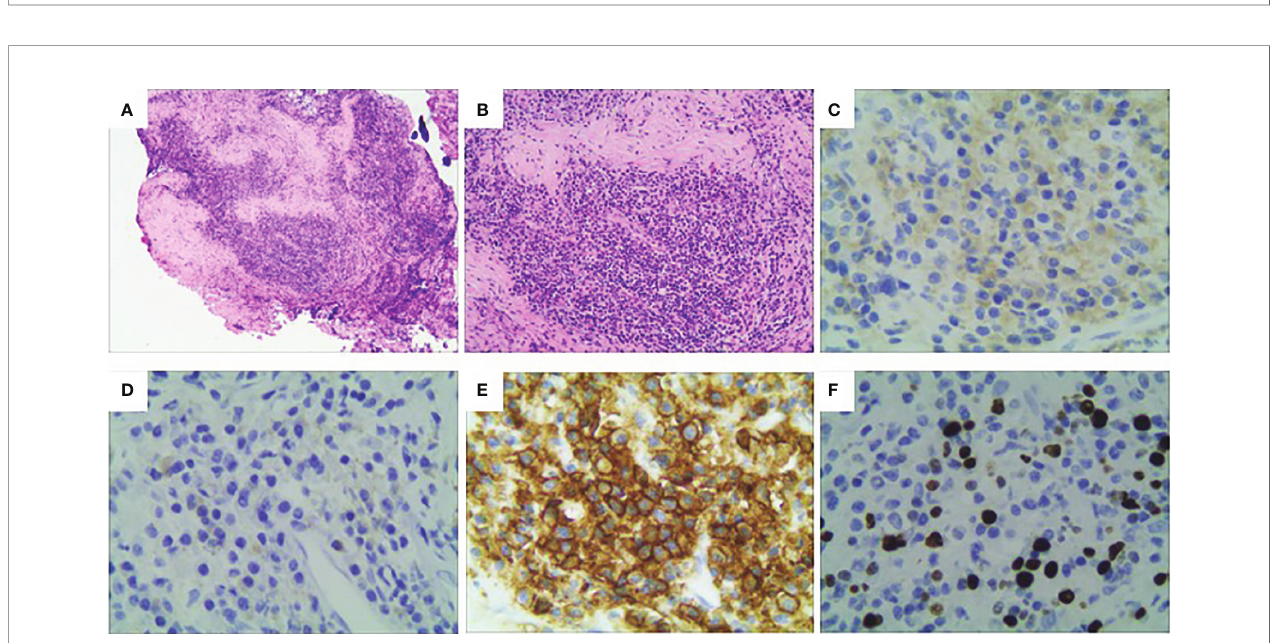
FIGURE 2 | Intra-operative condition of the lesion located at middle of upper clivus region. (A) the lesion was very tough and fi rm (the arrow); (B) the lesion was stick to the brain stem and basal artery (1: brain stem; 2: basal artery; 3: abducent nerve).